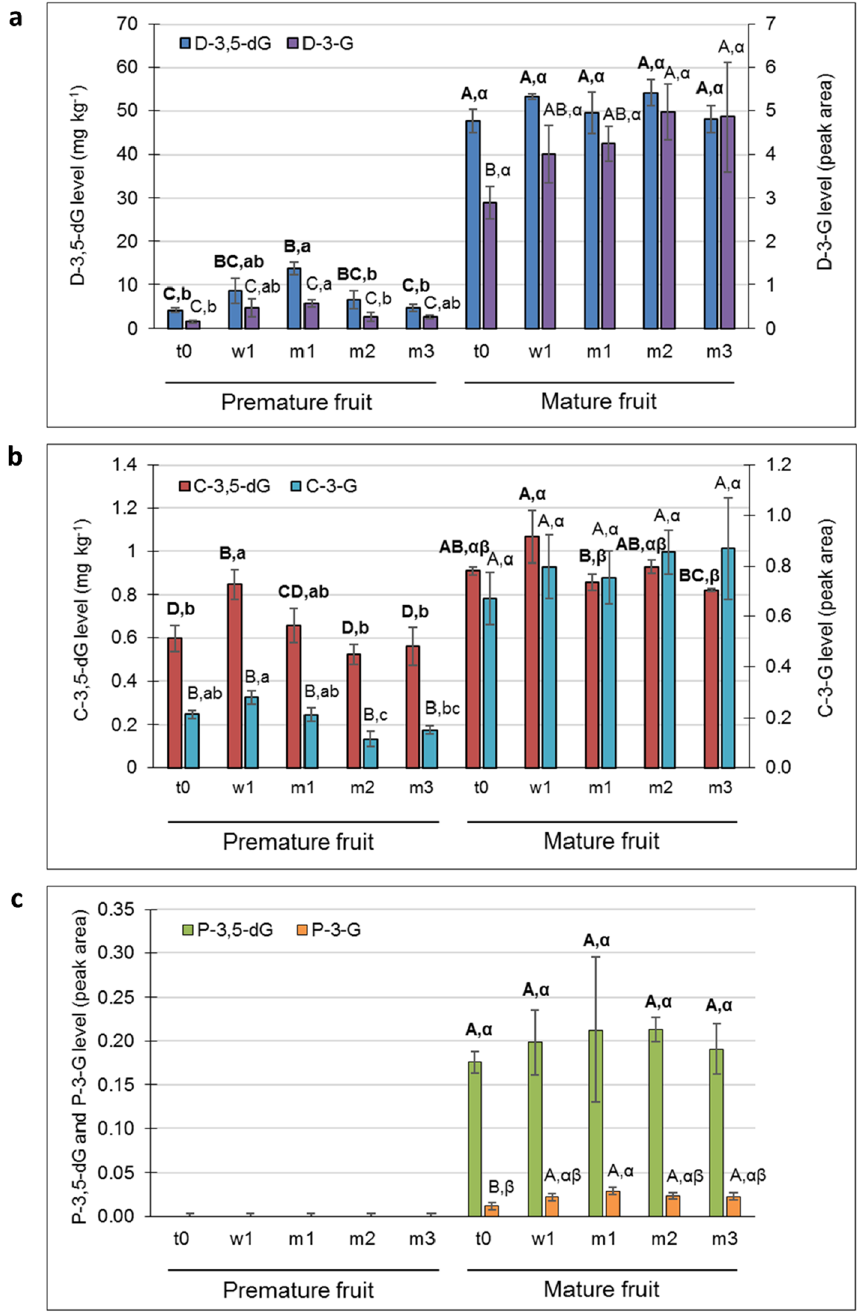
Figure 5. The mono- and diglucoside (dG) forms of the major anthocyanins: ( a ) delphinidin (D-3-G and D-3,5-dG), ( b ) cyanidin (C-3-G and C-3,5-dG), and ( c ) pelargonidin (P-3-G and P-3,5-dG), in the skin of premature and mature fruit. See Fig. 4 for abbreviations and letters of significance; bolded letters refer to the dG